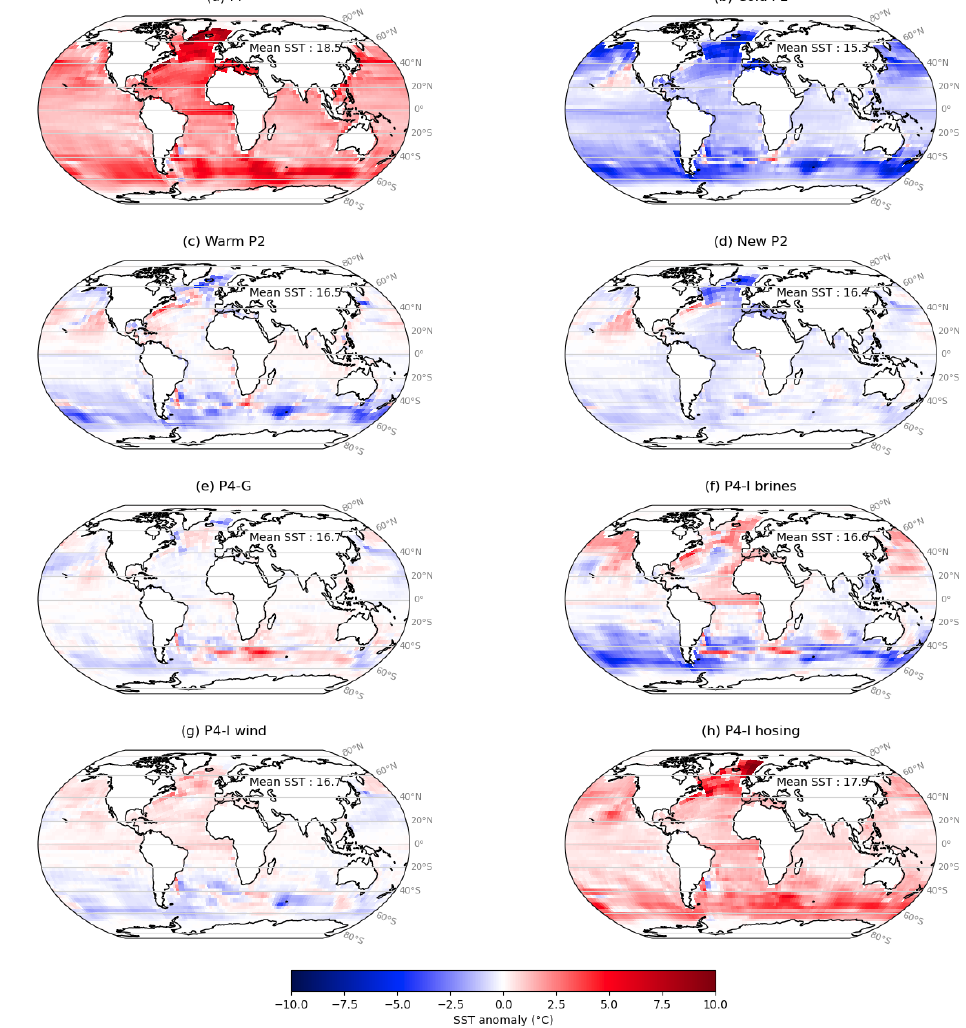
Figure 2. Anomaly in simulated mean sea-surface temperature ( ◦ C) relative to simulation “P4-I” (mean SST of 15.2 ◦ C). Due to the vertical resolution of iLOVECLIM, the sea-surface temperature is defined as the temperature of the first 10m of the water